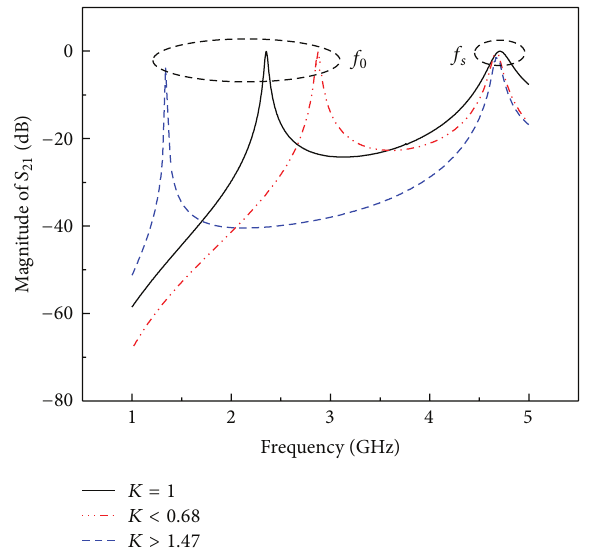
Figure 4: The fundamental frequency varied with the impedance ratio, 𝐾 . ( 𝜃 1 = 𝜃 2 ).